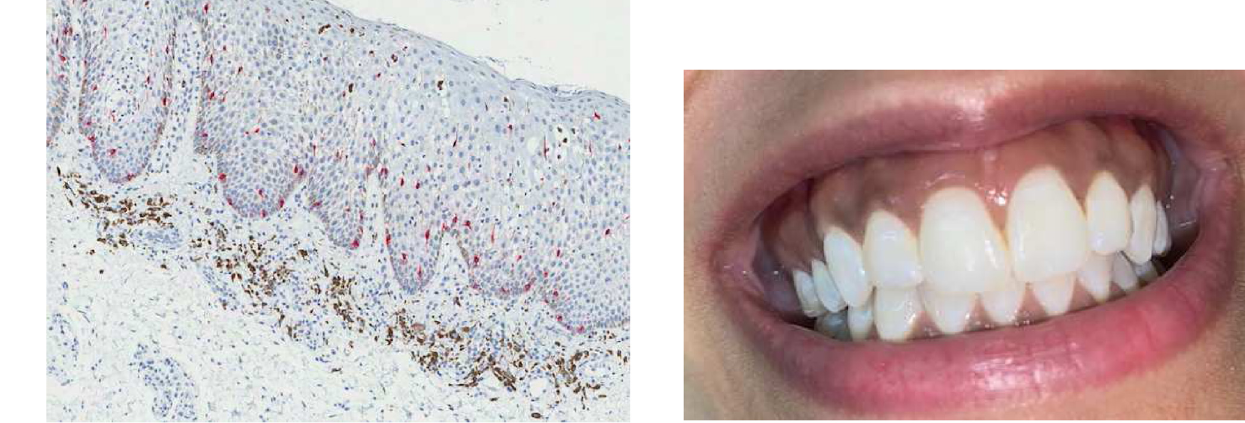
Figure 3. Microphotograph of Melan-A stained biopsy tissue. Microphotograph of Melan-A stained biopsy tissue shows melanotic hyperplasia in the epithelium.